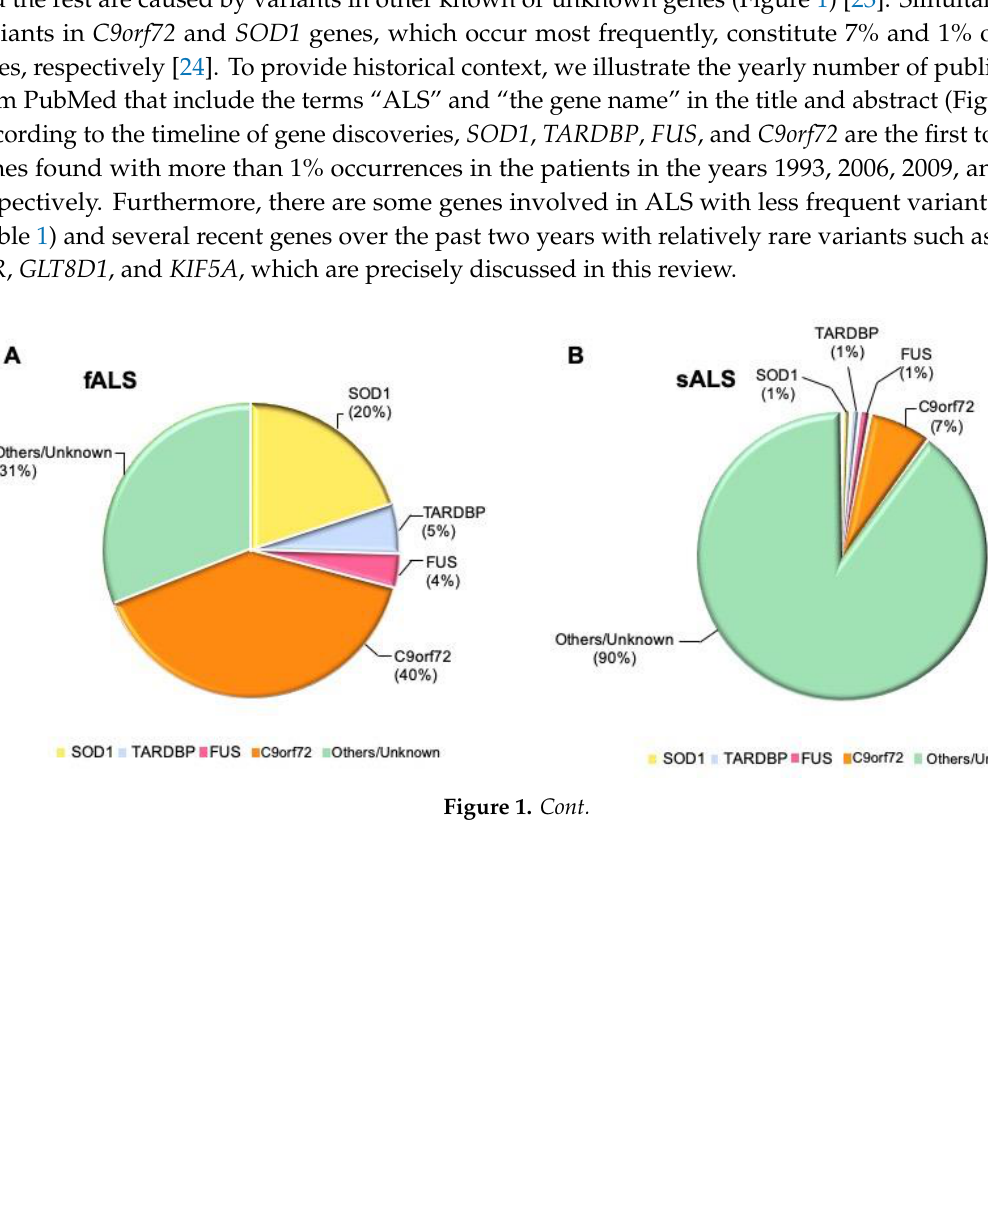
Figure 1. Proportional contribution of mutated genes in ALS and timeline of ALS gene study. ( A ) The p roportion of mutant genes in fALS cases. ( B ) The proportion of mutant genes in sALS cases. ( C ) Timeline of ALS gene discoveries and researches for SOD1 , TARDBP , FUS, and C9orf72 . The Y -axis shows the number of publications in PubMed that include the terms “ALS” and “the gene name” by year until November 2020. Table 1. Genes known to carry ALS-causing mutations. Gene Cases/Control